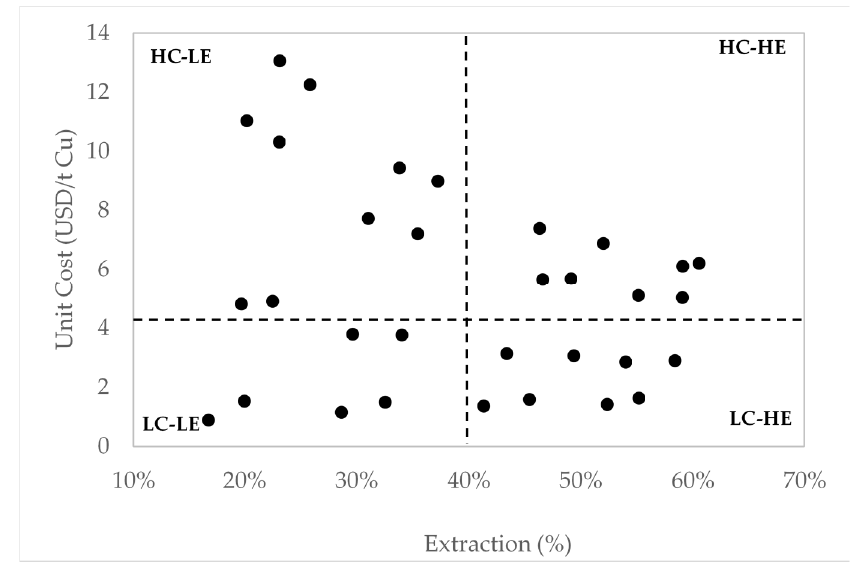
Figure 6. Representation of different economic evaluation subsets. On the other hand, subset LC-HE represents experiments with a low cost and high extraction. The average unit cost in this subset is 2.2 USD/t Cu, and the average extraction is 50%. These experiments include high concentrations of hydrogen peroxide. In cases with the lowest unit cost, the concentrations of KI and NaIO 3 are zero. The maximum extraction percentage achieved in this subset is 58.4%, with a unit cost of 2.9